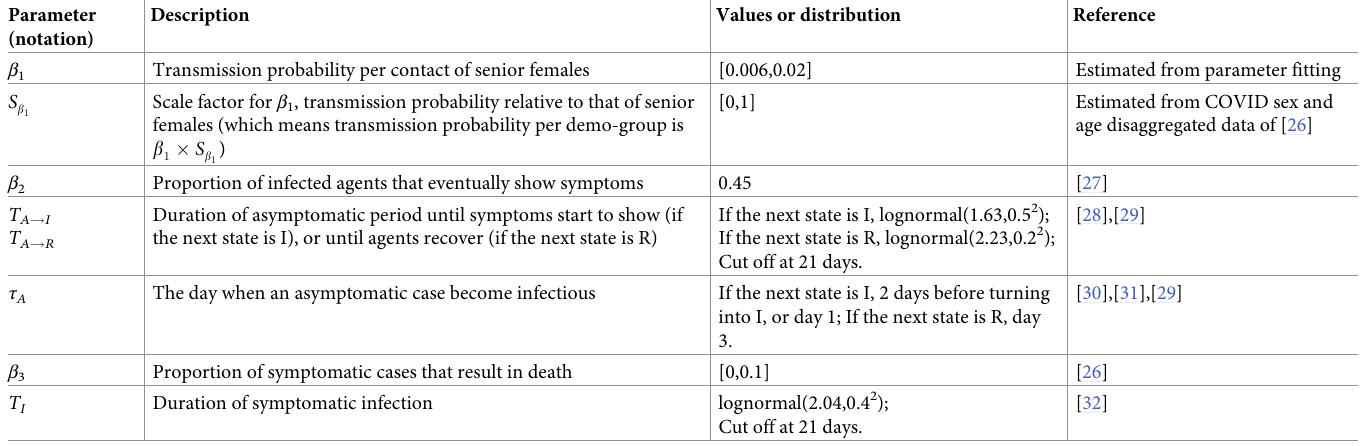
Table 1. Selected simulation model parameter values and